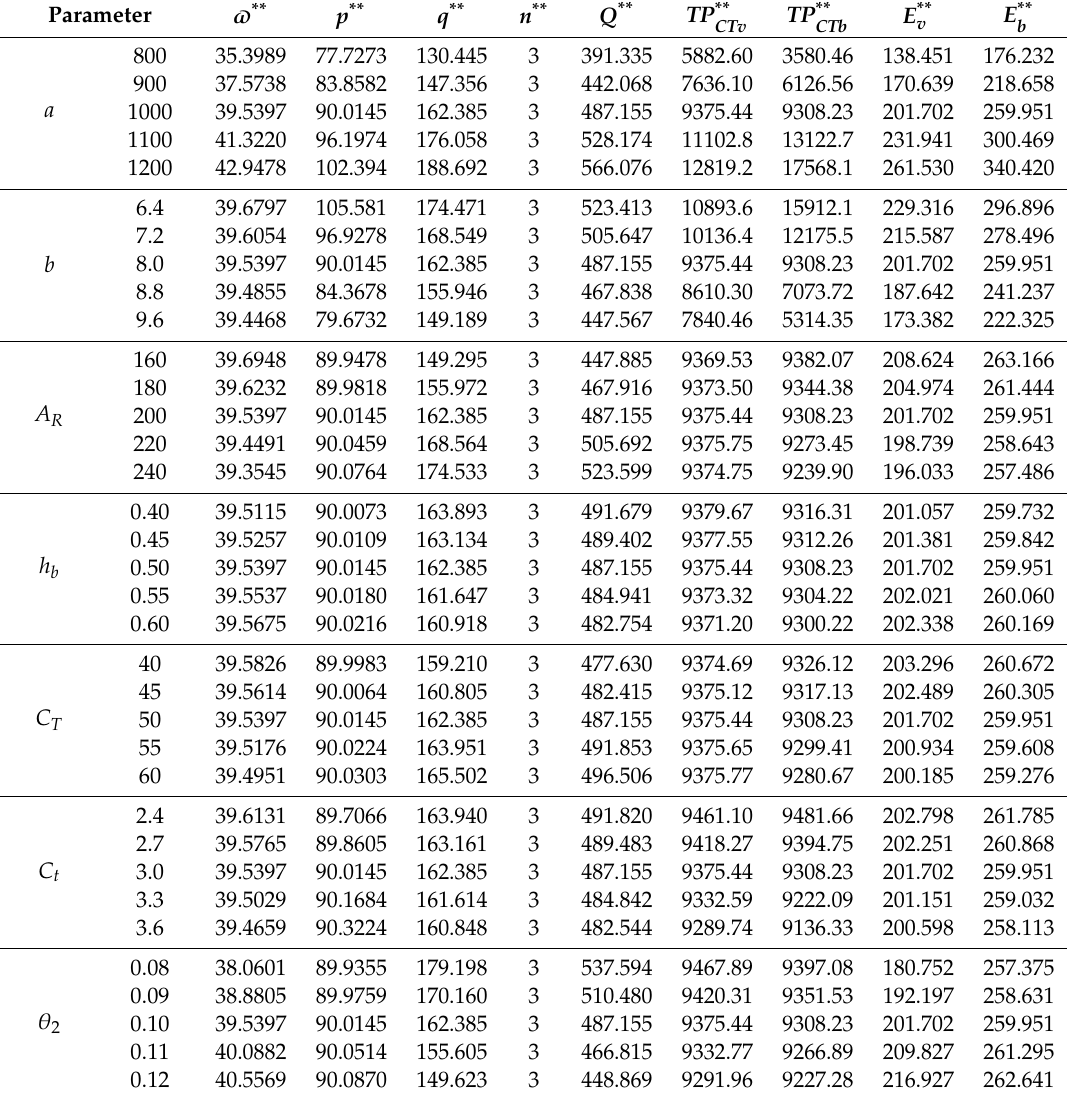
Table 4. Sensitivity analysis of the retailer’s parameters in Example